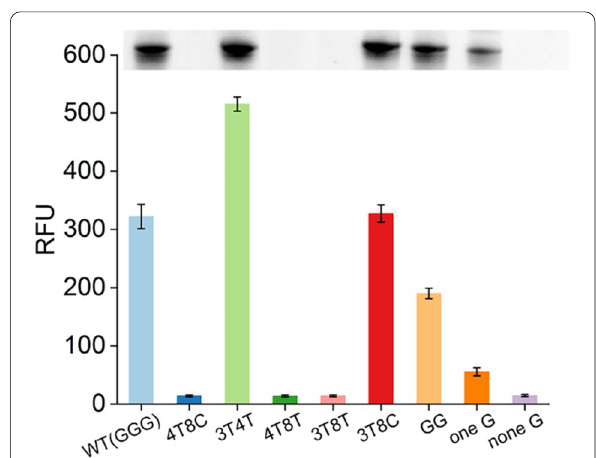
Fig. 7 Transcription efficiency of combined mutants and truncated mutants quantified by STAR. The X ‑axis represents different mutants, the Y ‑axis represents the relative fluorescence units. Error bars represent the standard deviation of the triplicate experiments, P < 0.02. The inset shows the results of denaturing polyacrylamide gel electrophoresis analysis of the 60‑min transcription